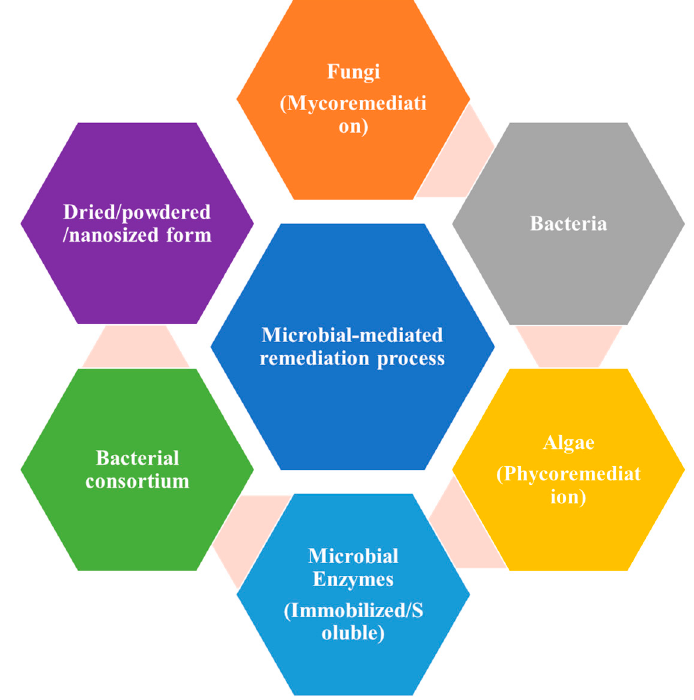
Water 2022 , 14 , x FOR PEER REVIEW